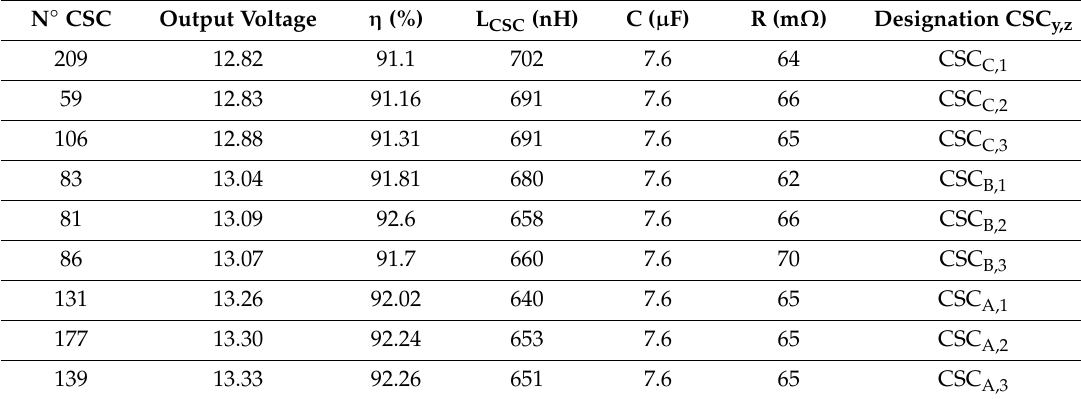
Table 4. R-L-C component values for the equivalent circuit of the 3 × 3